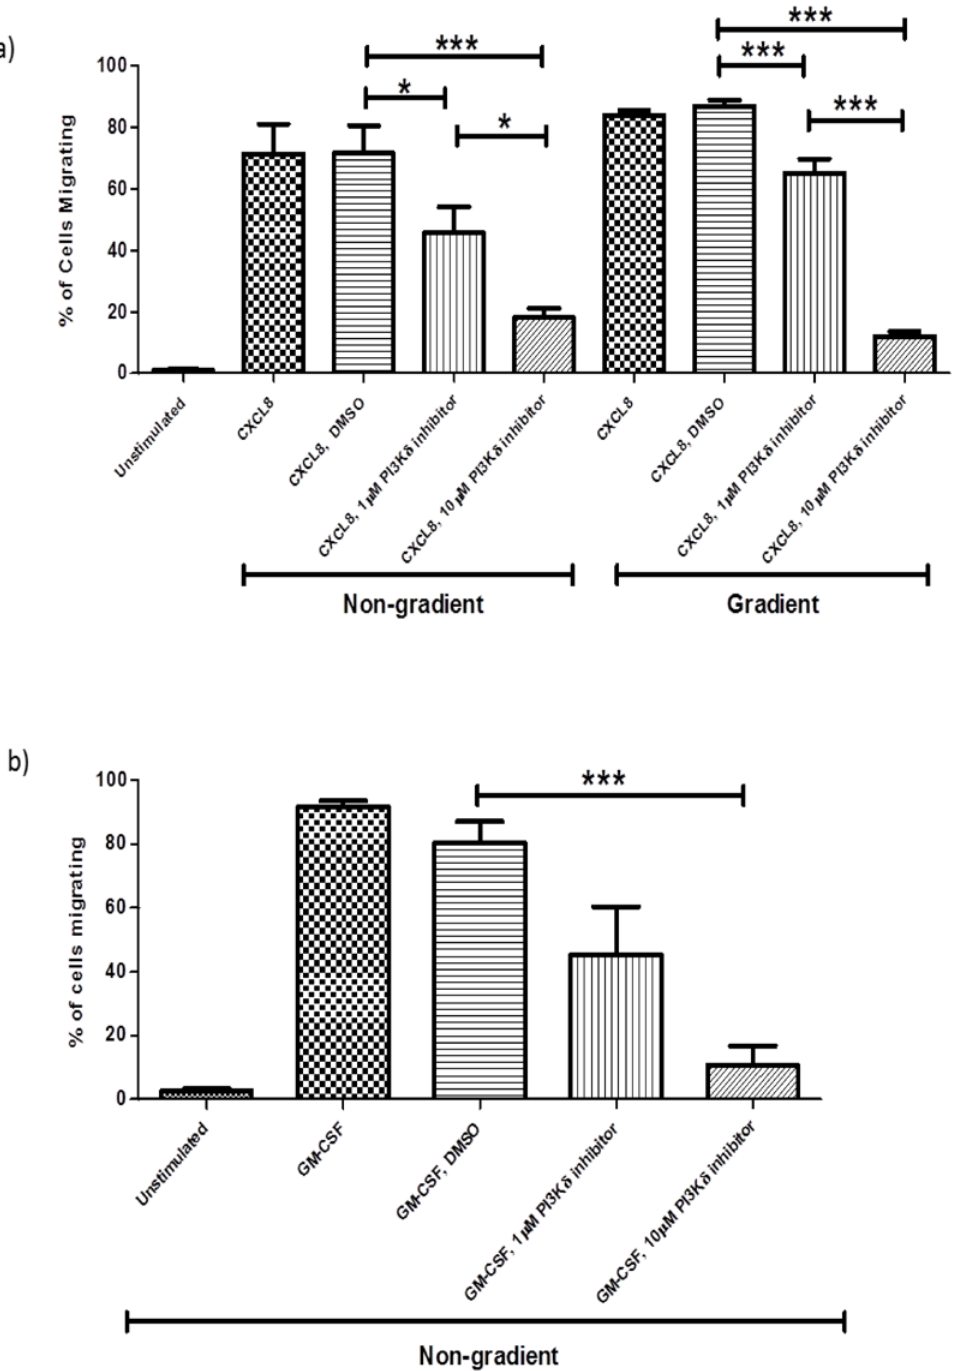
Fig 5. An antagonist of PI3K δ inhibits both chemotactic and chemokinetic migration mediated by CXCL8 and GM-CSF-. Neutrophils were treated with 1 μ M and 10 μ M of the PI3K δ selective inhibitor PIK-274 for 30 mins prior to the addition of CXCL8 (100ng/ml, a) or 0.5ng/ml GM-CSF (b). Data shown are mean ± SEM (n = 3) except for gradient DMSO and 1 μ M of PIK-274 where n = 8. * p < 0.05, *** p < 0.001.